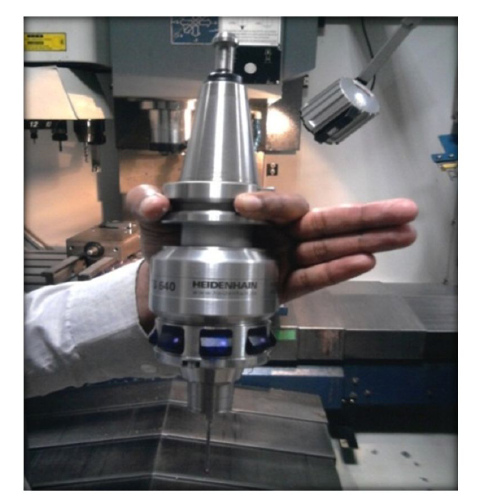
Fig. 4. Touch probe for measuring delamination